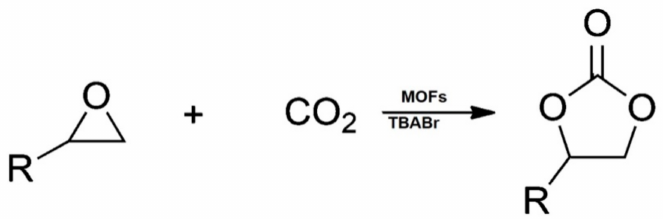
Figure 3. General scheme for cycloaddition reaction of CO 2 and epoxide using metal-organic frameworks (MOF) catalysts and tetrabutylammonium bromide (TBABr) as co-catalyst.